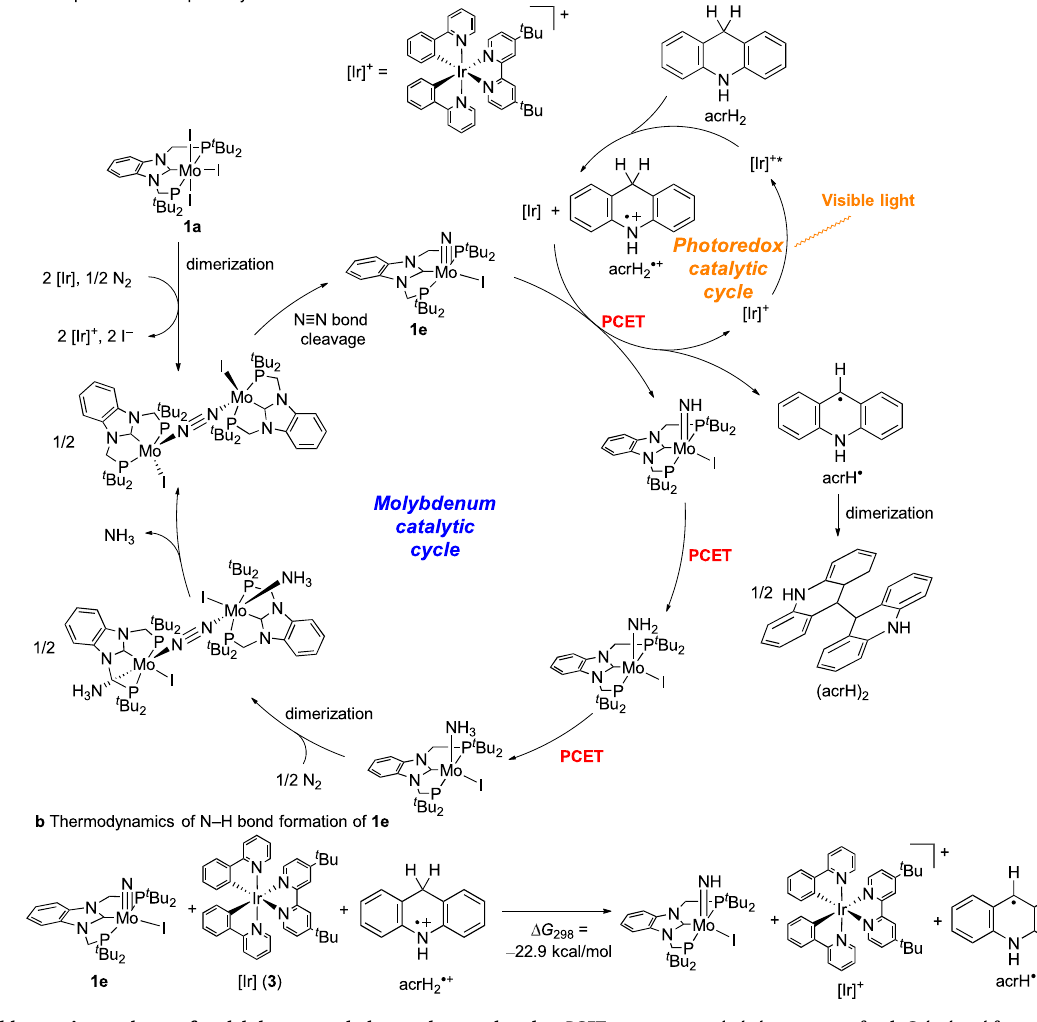
Fig. 5 | Possible reaction pathway of molybdenum- and photoredox-catalysed ammoniaformation.a Proposedreactionpathwayofreductionofdinitrogeninto ammonia using visible light energy by molybdenum- and photoredox